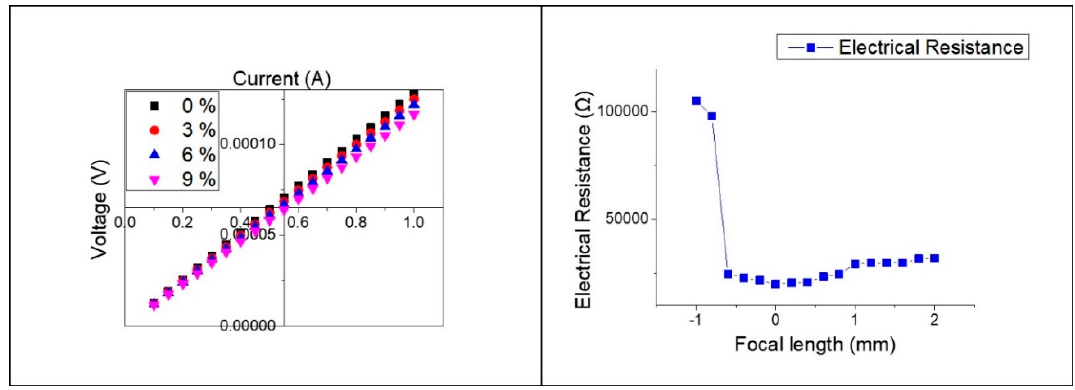
Figure 9. ( a ) Electrical response of LIG strain sensor; ( b ) Change of initial electrical resistance according to focal length.